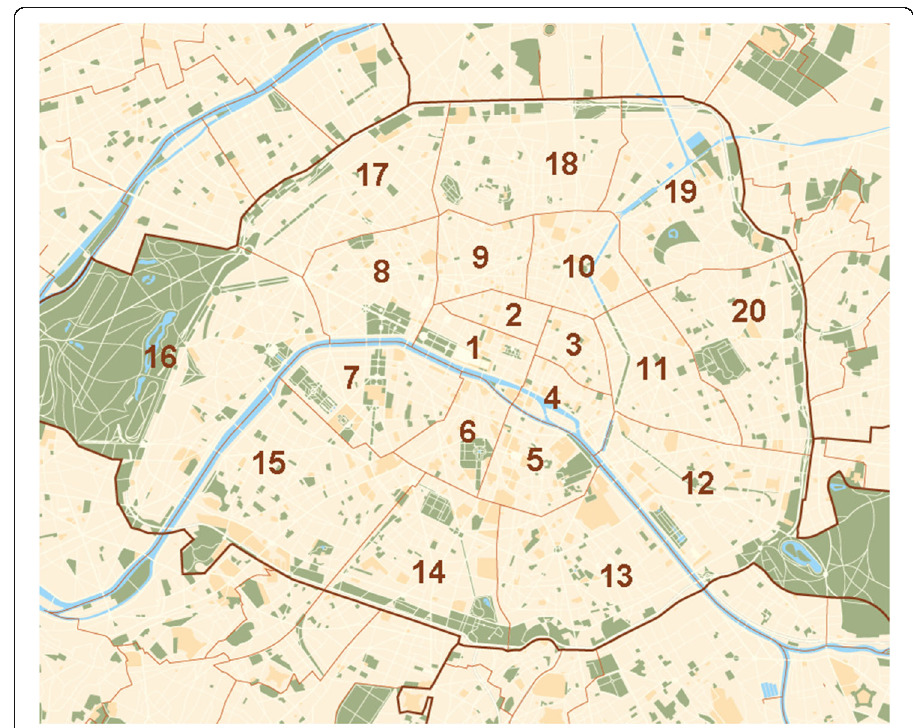
Fig. 2 Map of the Parisian Arrondissement s and metropolitan